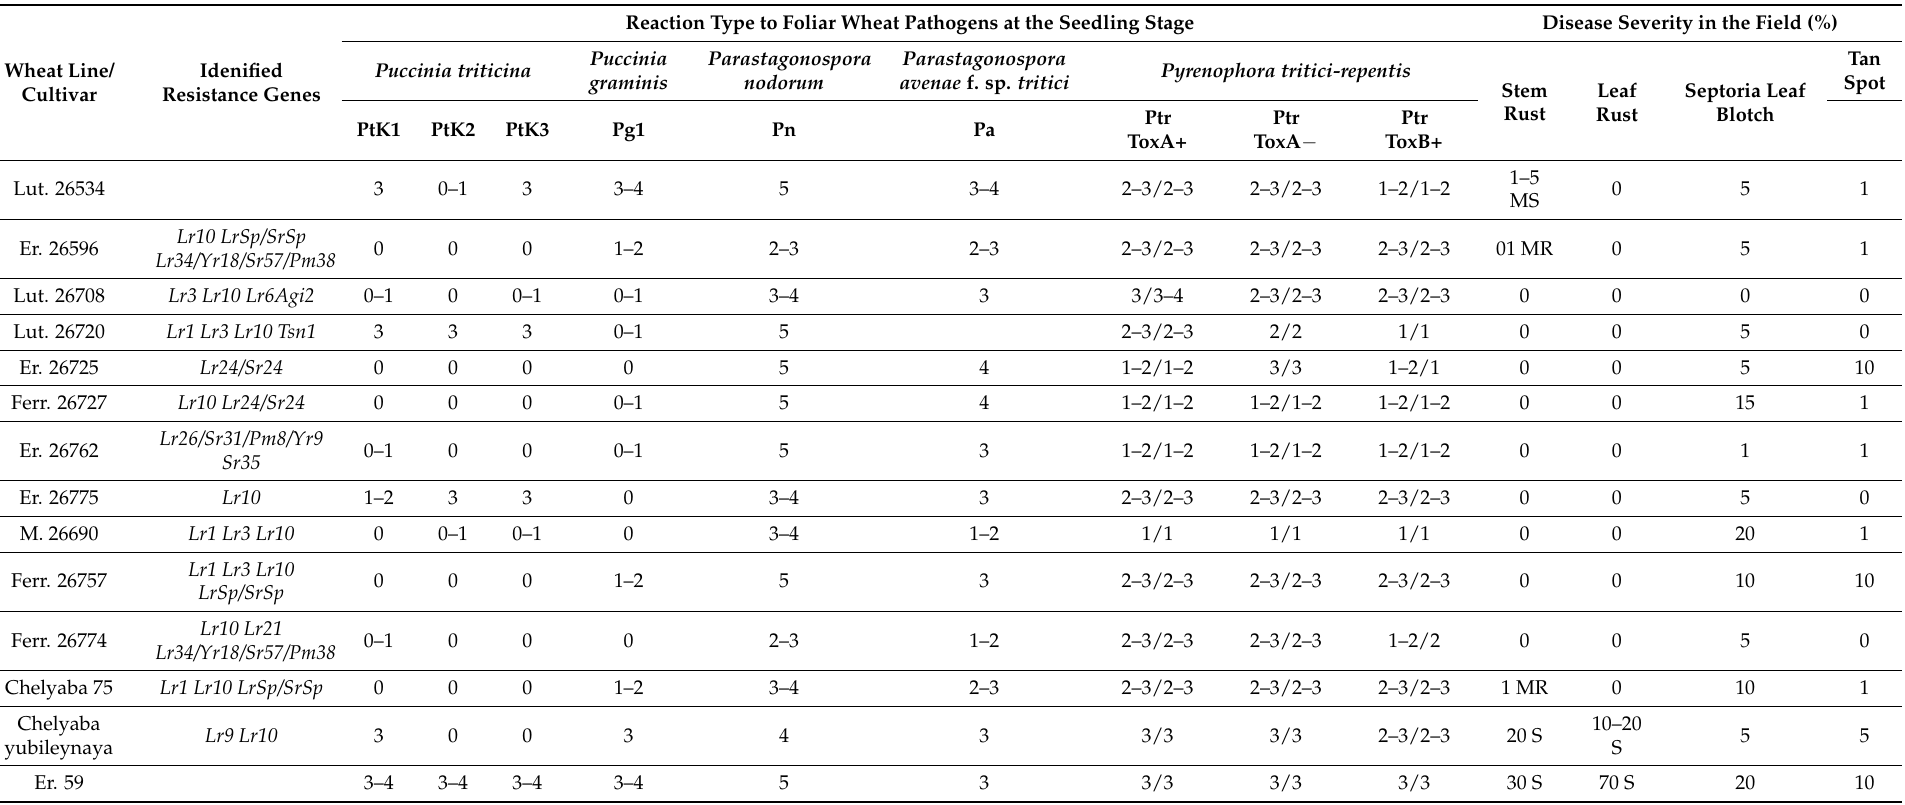
Table 2. Reaction of breeding lines and cultivars produced at the Chelyabinsk Research Institute of Agriculture (ChRIA) to foliar diseases in seedling and adult plant stages (2019–2020).